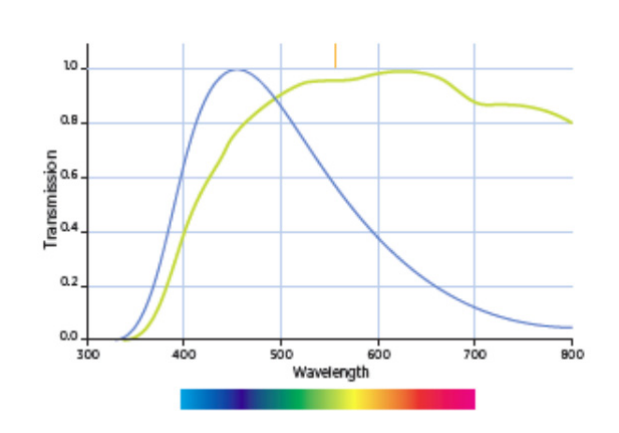
Fig. 4 Transmission spectra of light coming through EC glass in the fully clear (green line) and fully tinted (blue line)